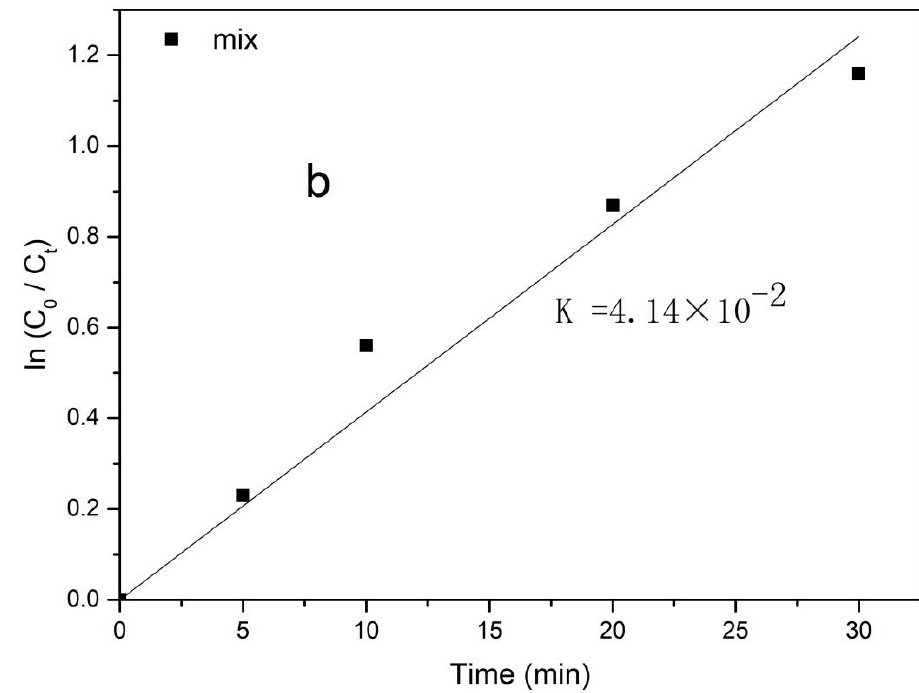
Figure 4. EDDS-modified photo-Fenton degradation of a mixture of 2,4-DCP and 2,4,6-TCP in the two-pollutants experiment (( a ) 2,4-DCP and 2,4,6-TCP degradation efficiency; ( b ) apparent rate constant of degradation of mixed pollutants). [2,4-DCP] = 10 mg L − 1 , [2,4,6-TCP] = 10 mg L − 1 , [Fe(III)-EDDS] = 0.1 mM, [H 2 O 2 ] = 1.0 mM, and pH = 7.0 ±